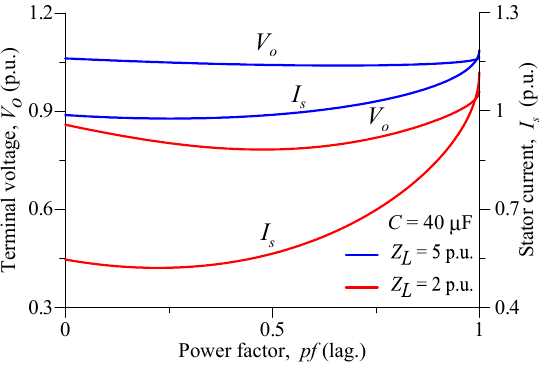
Figure 10. Terminal voltage V o and Stator current I s versus power factor pf for different loads at fixed speed ( u = 1.0 p.u. ).